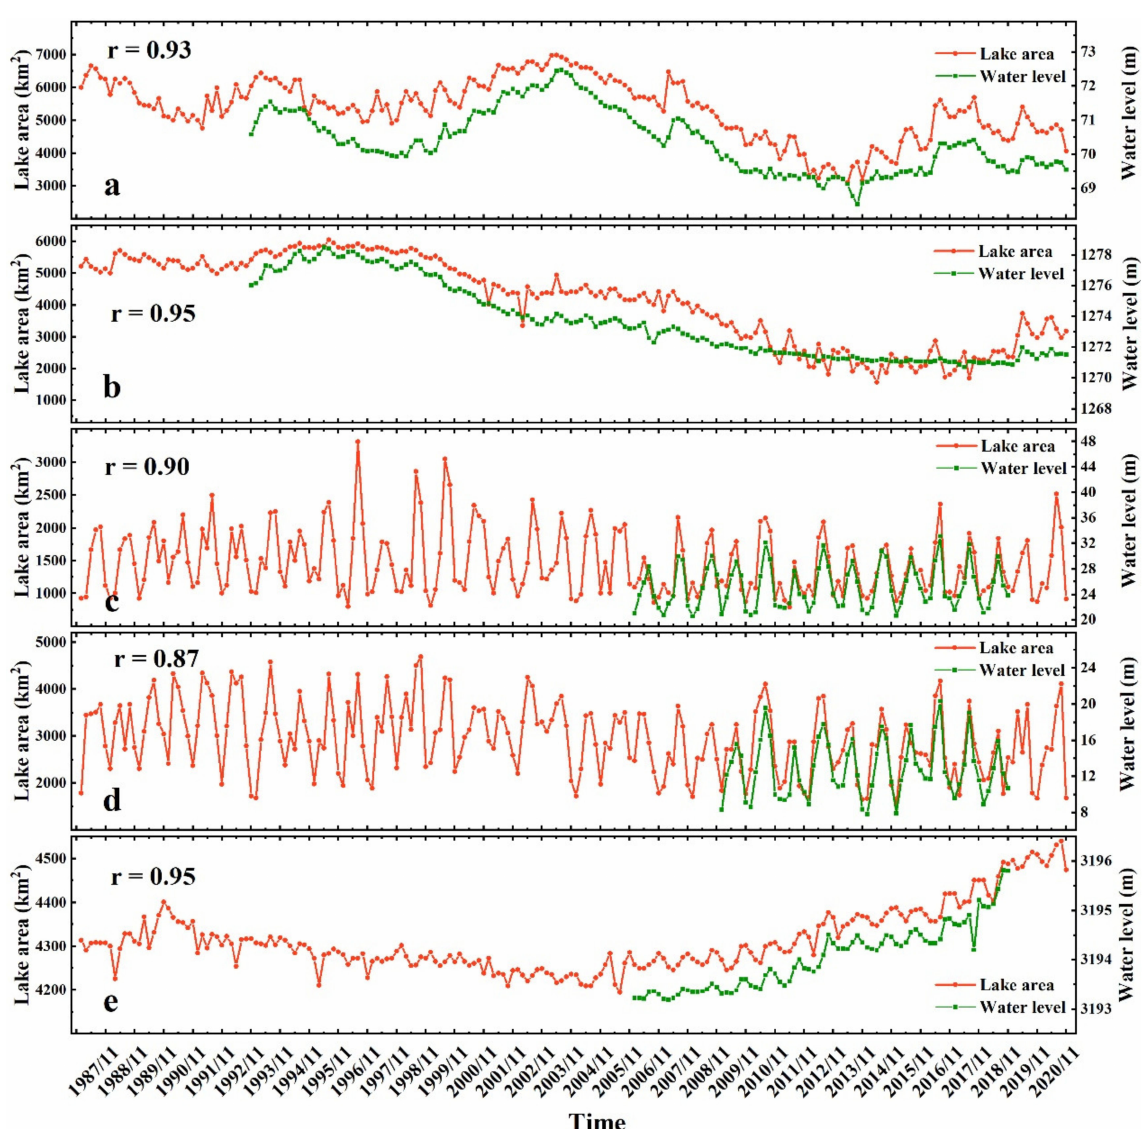
Figure 11. Comparison and correlation analysis between BSWD lake area with water level series for ( a ) Chiquita Lake, ( b ) Urmia Lake, ( c ) Dongting Lake, ( d ) Poyang Lake, and ( e ) Qinghai